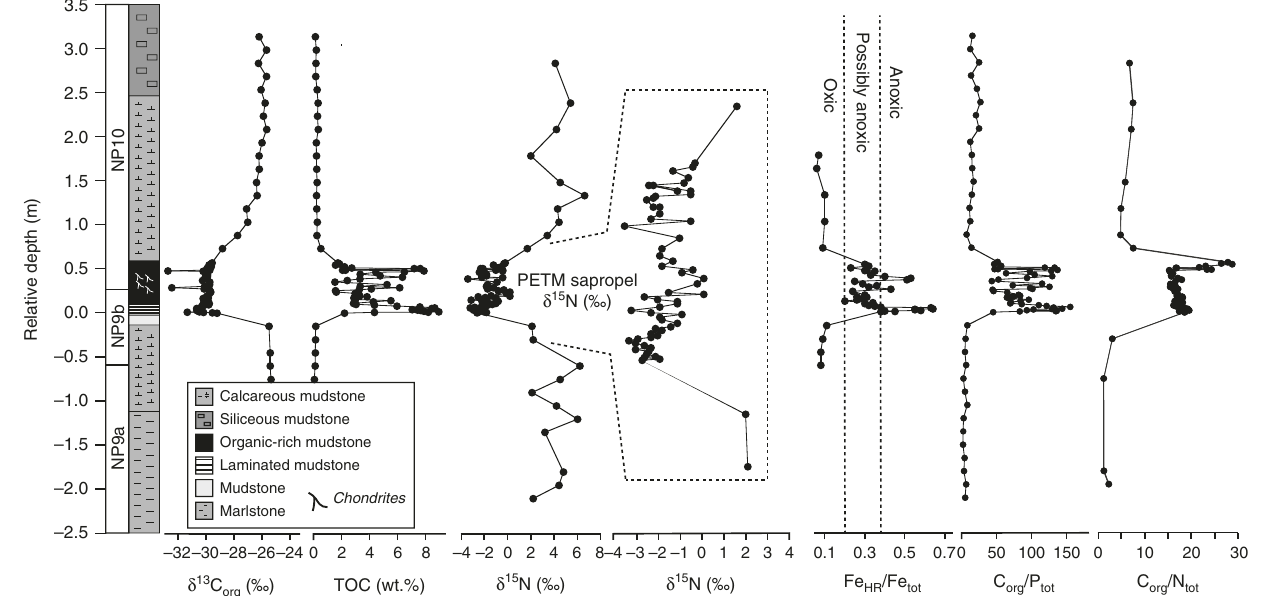
Fig. 2 Geochemical data from the Kheu River section. Primary variability in the nitrogen data re fl ect the facies shifts that correspond to the transitions into and out of the interval of sapropel deposition. Nitrogen-isotope data between the calcareous shales and the interbedded sapropel do not overlap, and underscore the differences in sapropel and non-sapropel geochemical conditions (Fig. 3)